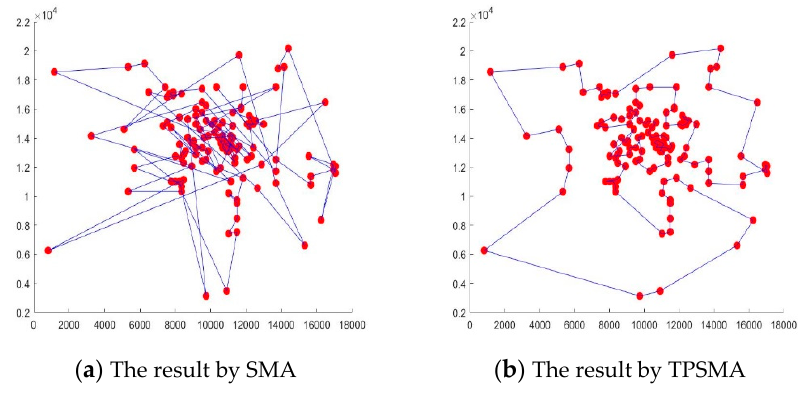
Figure 9. The simulation of bier127.